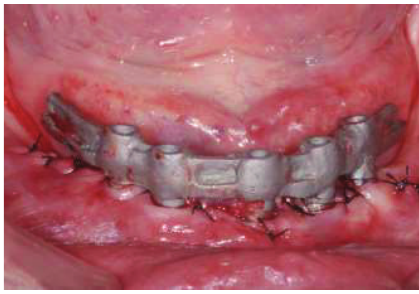
Figure 6: Framework try-in.